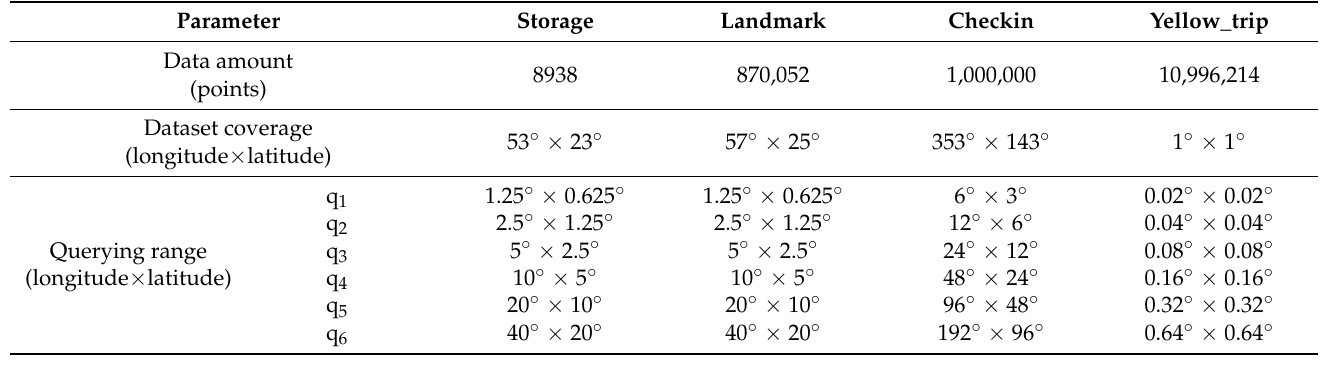
Table 1. Experimental datasets and querying range